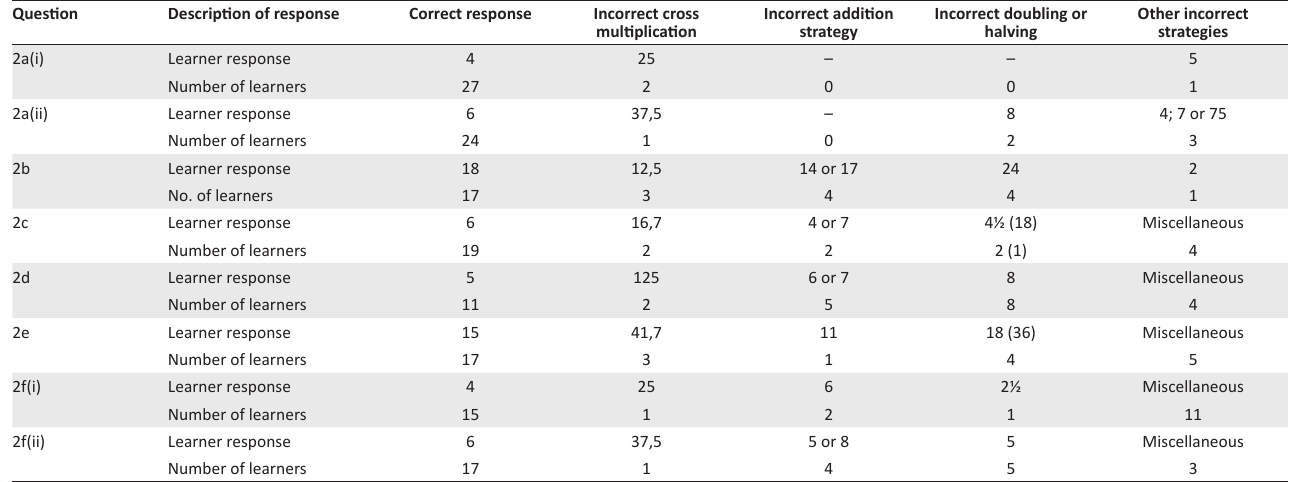
TABLE 3: Learner responses to Question 2 ( N = 30).